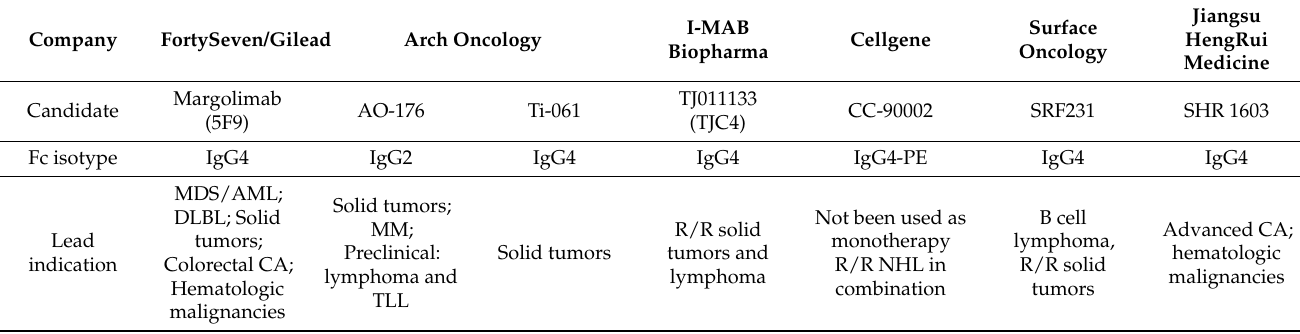
Table 1. Anti-CD47 monoclonal antibodies.